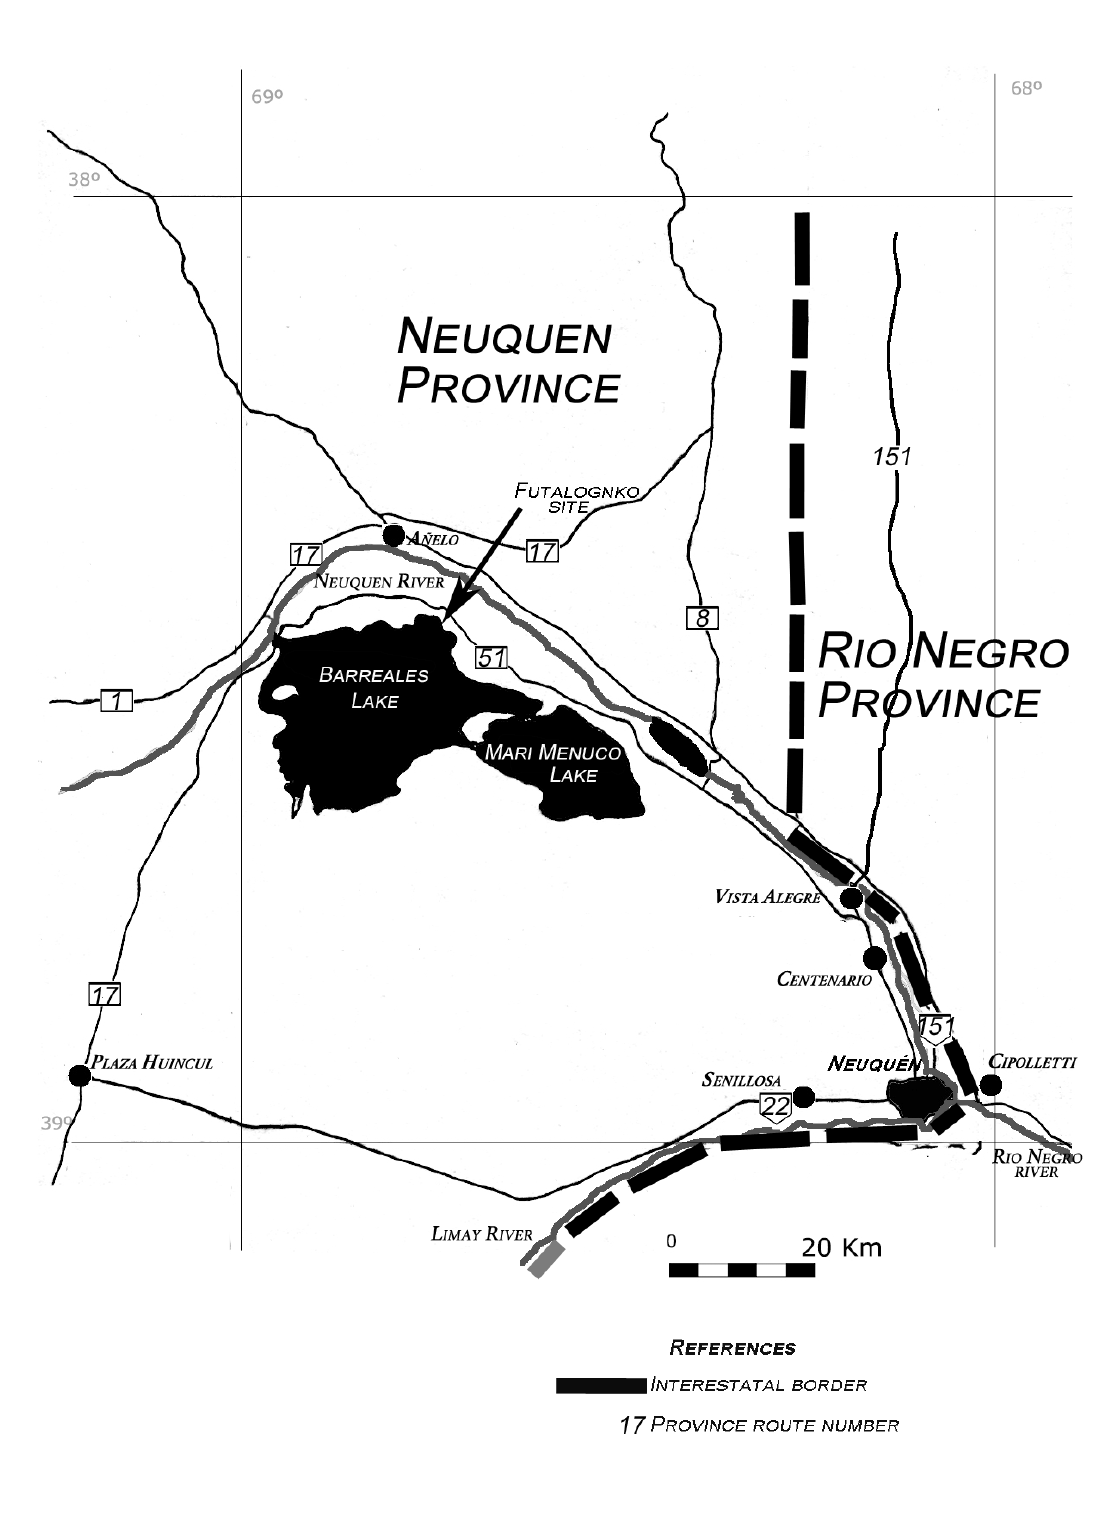
Figure 1 - Map showing the locality (dark arrow) where Argentinadraco barrealensis n. gen, n. sp. was